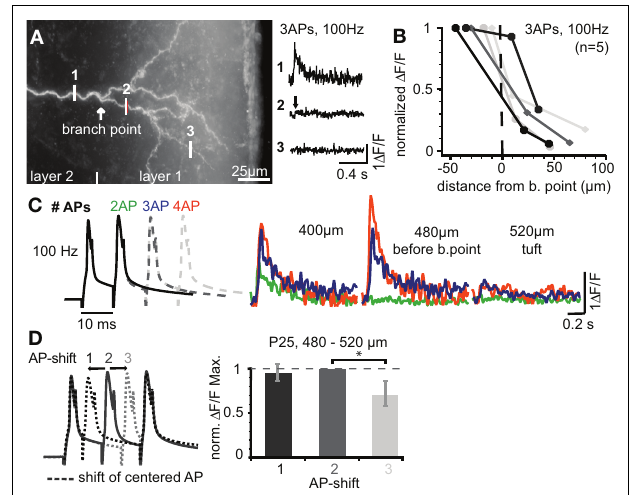
FIGURE 4 | Ca 2 + signals steeply drop within the apical dendritic tuft. (A) Photograph of the apical tuft region of a L5A pyramidal neuron indicating the positions for Ca 2 + imaging with respect to the major BP. Ca 2 + signals were produced by a train of three APs at 100 Hz and strongly attenuated beyond the BP (position 2). (B) Δ F/F Ca 2 + signals plotted as a function of distance from a position close to the BP ( n = 5). (C) Δ F/F Ca 2 + signals were evoked by short trains of 2–4 APs at 100 Hz and measured at three distances before the BP and within the tuft. (D) Dendritic Ca 2 + signals depend on changes in instantaneous ISIs. Trains of three APs at 100 Hz (regular train) were compared with those in which the 2nd AP was shifted ± 5 ms in a region ∼ 500 µm from soma before the BP ( n = 5). Δ F/F Ca 2 + signals were normalized to the regular AP train. Data for this fi gure were from P14 (A–C) and P25 (D) (apical ∼ 800 µm versus basal dendrites ∼ 160 µm), we compared